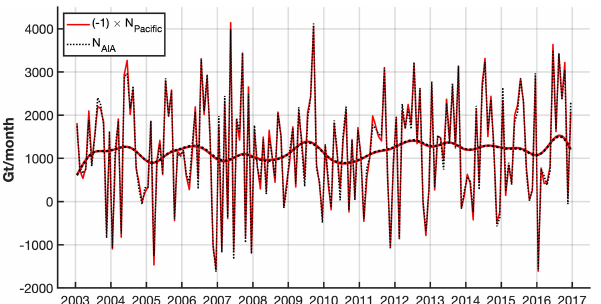
Figure 3. Monthly time series of WT flux from the Pacific to the AIA oceans. The red curve is (the opposite of) the Pacific outflow, and the black curve is the AIA inflow. Thick lines are the low-pass- filtered signal by a Hann function of 24